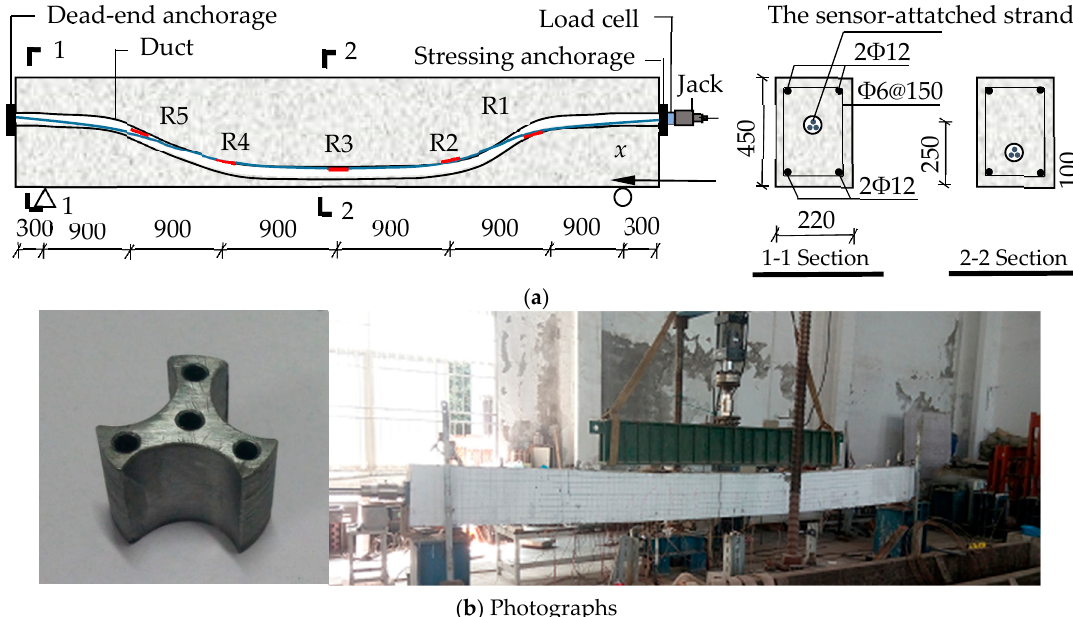
Figure 8. Sketches and photographs of the experiment. ( a ) Applied tensioning to tendons; and ( b ) photographs of the restraining block and tensioning.